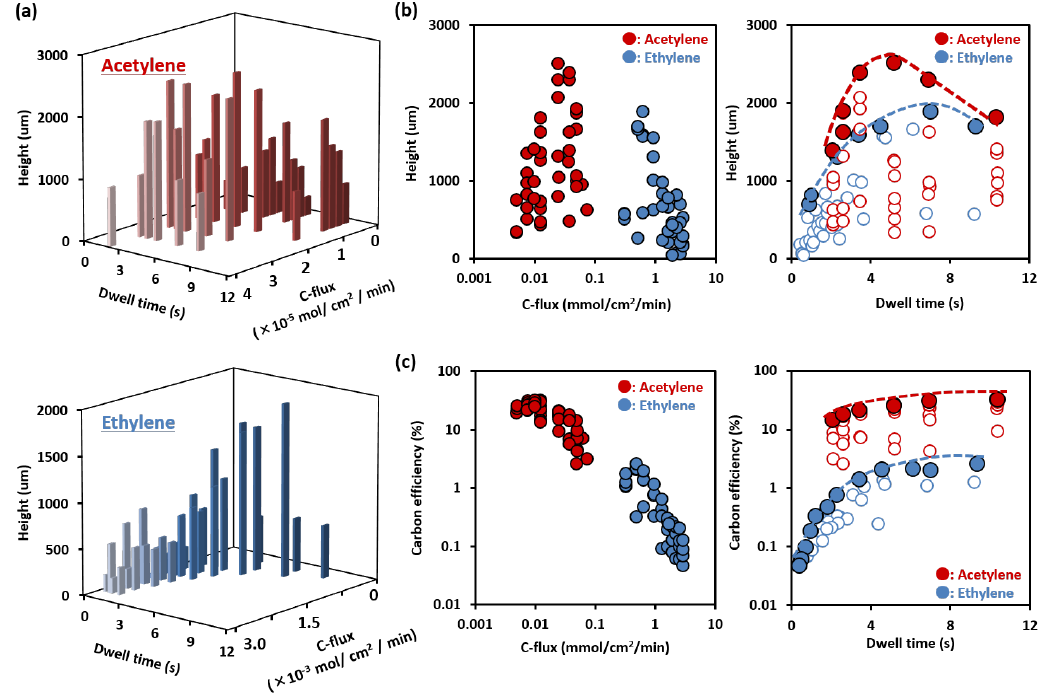
Figure 1. ( a ) Three-dimensional mapping of single-walled carbon nanotubes (SWCNTs) height as functions of dwell time and carbon flux for acetylene (upper), ethylene (lower); ( b ) Two-dimensional mapping of SWCNT height as a function of dwell time and carbon flux. Peak positions at each dwell time are marked as solid circles; ( c ) Carbon efficiency as a function of the dwell time and carbon flux. Peak positions at each dwell time are marked as solid